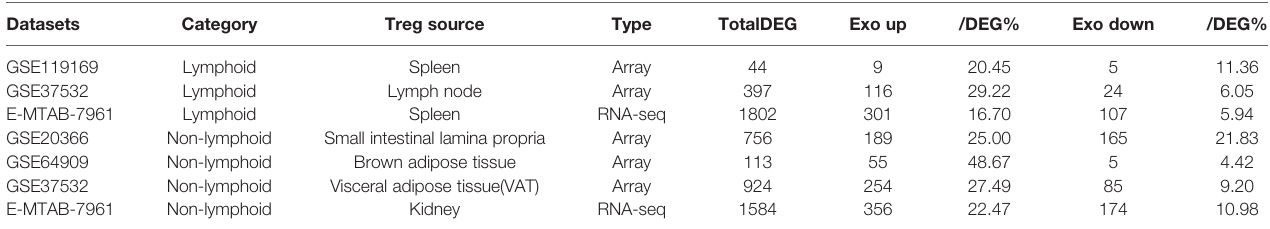
TABLE 3A | 70.6% (20/34) speci fi c exosome pathways were in E-MTAB-7961 kidney tissue Treg. A list of human 6560 exosome genes were collected. A. Exosome gene numbers in normal Treg groups. Datasets